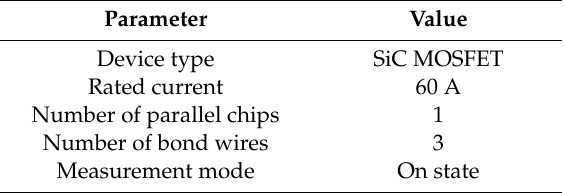
Figure 8. Structure functions of Sample 1, with the structural layers identified. Table 2. Parameters of the sample used for the experiment in Section 3.1.2 and Section 3.2.1.